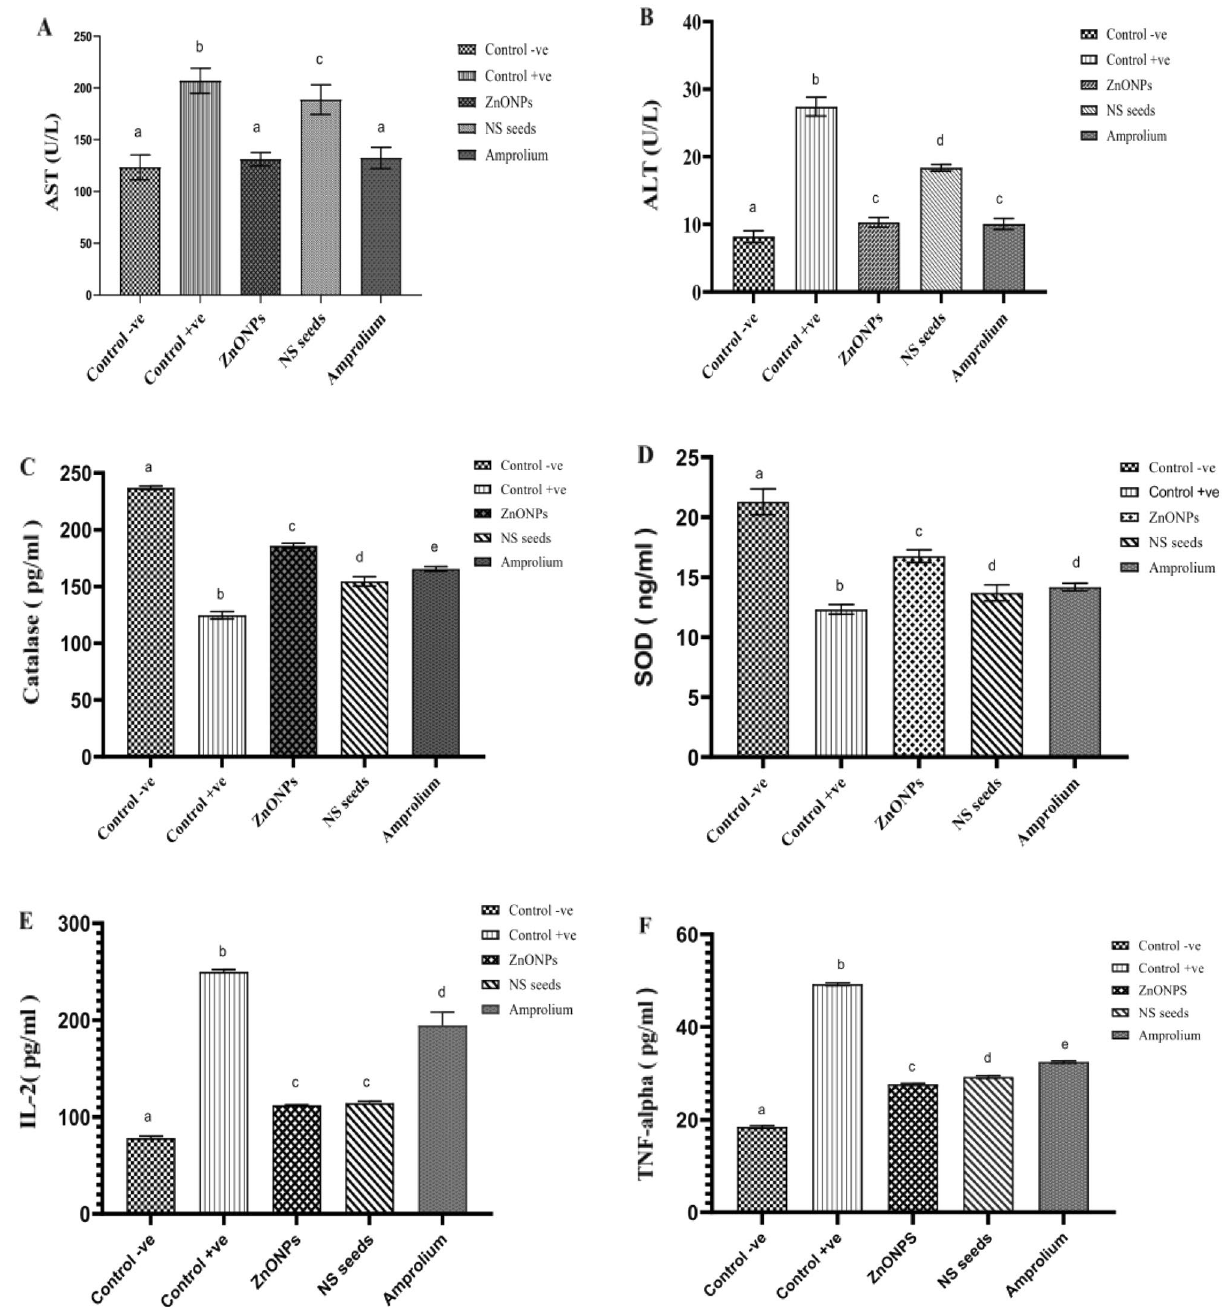
Figure 9. Serum biochemical profile, Antioxidant status, and level of inflammatory cytokines of the broilers challenged with Eimeria tenella and given different treatments ( A ) Aspartate transferase, ( B ) Alanine transferase, ( C ) Catalase, ( D ) Superoxide dismutase, ( E ) Interleukins-2, ( F ) Tumor necrosis